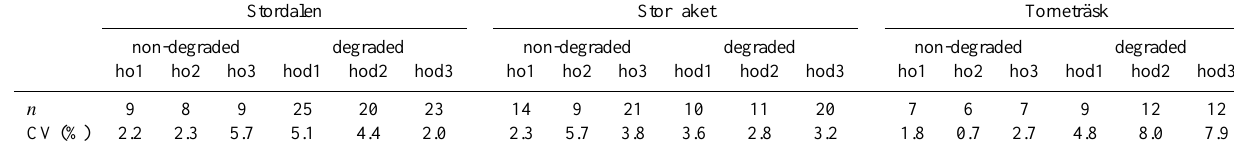
Table 3. Coefficient of variation (CV) of δ 13 C [‰] at hollows and degraded hollows. Stordalen Storflaket Torneträsk